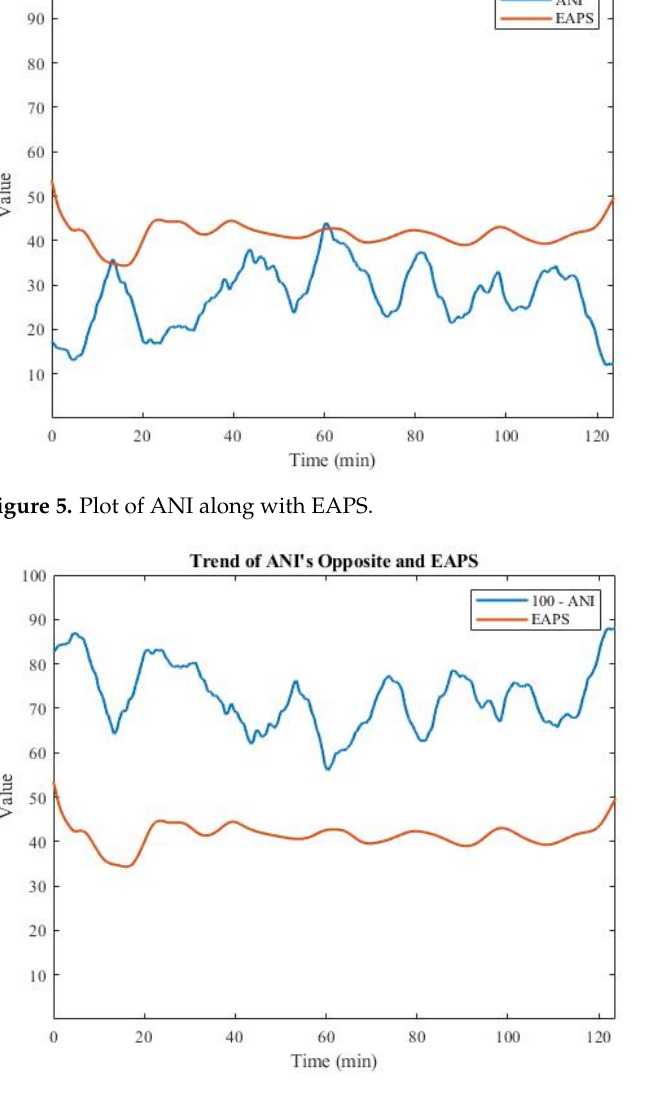
Figure 6. Plot of the opposite of ANI, along with EAPS.